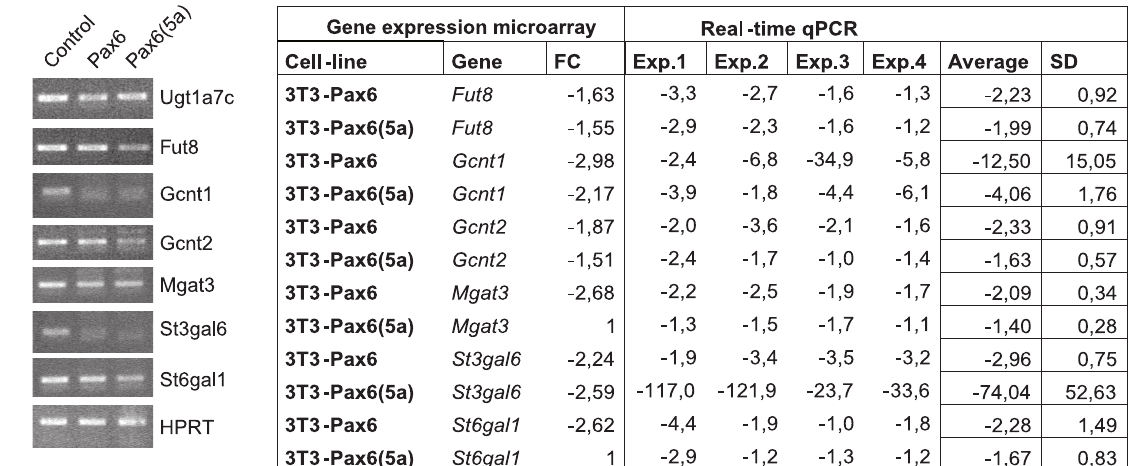
table 5: Ncam1 , Pdgfb , Ngef , Dkk3 and Hist1h1c (upregulated) and Sphk1 and Nbl1 (downregulated). The overall result confirmed the gene expression microarray data, though there were differences in the fold regulation compared to the microarray. However, most of the genes seemed to be regulated by Pax6 in addition to Pax6(5a), even though Pax6(5a) regulation was more prominent (Fig. 5).